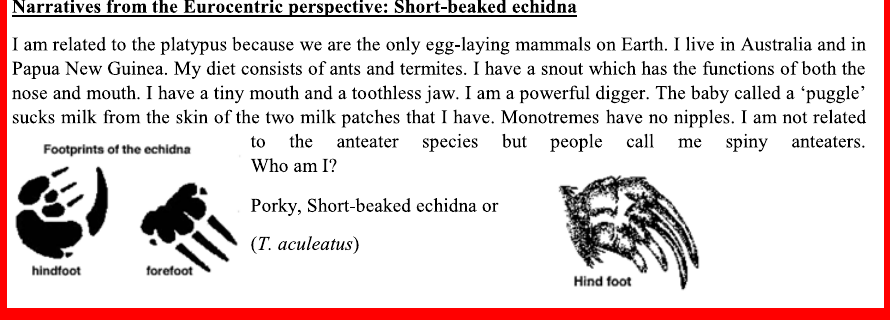
Fig. 2. Non-Aboriginal zoology narrative: Who am I game; Short-beaked echidna ( T. aculeatus ).